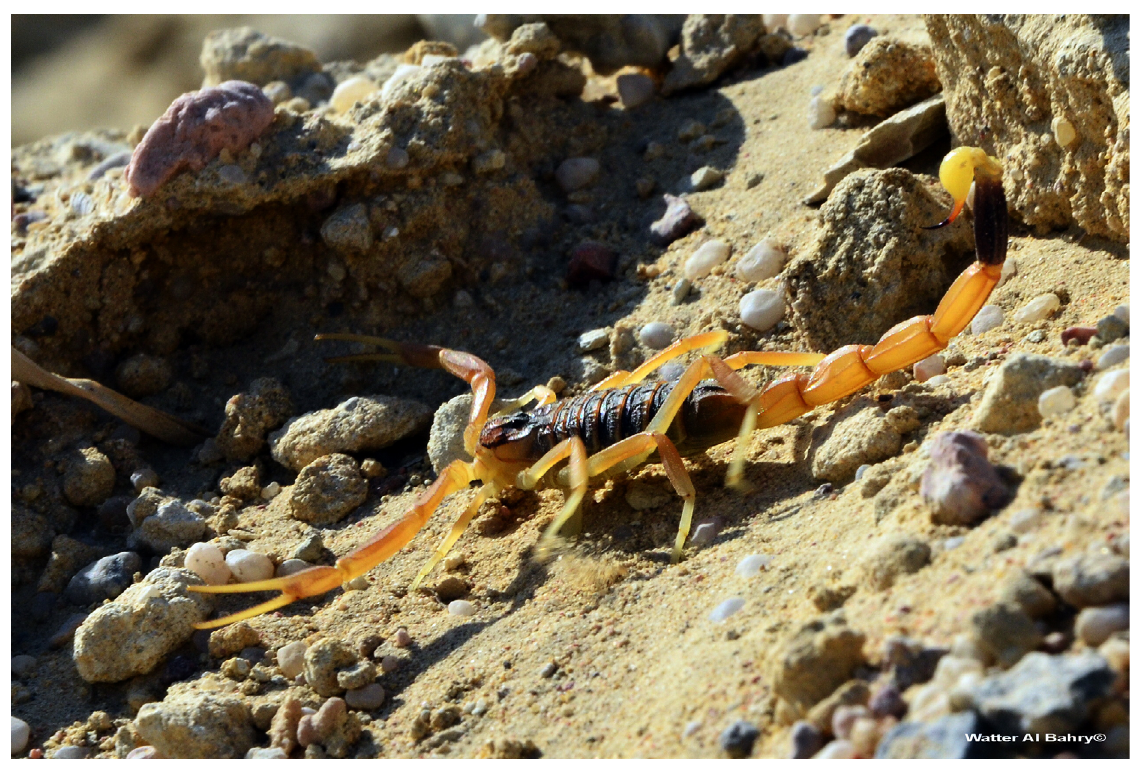
Figure 1. Pre-adult male of Leiurus quinquestriatus in its natural habitat, Hurghada Eastern Desert, Red Sea, Egypt (copyright by W. Al Bahry, reproduced with permission).